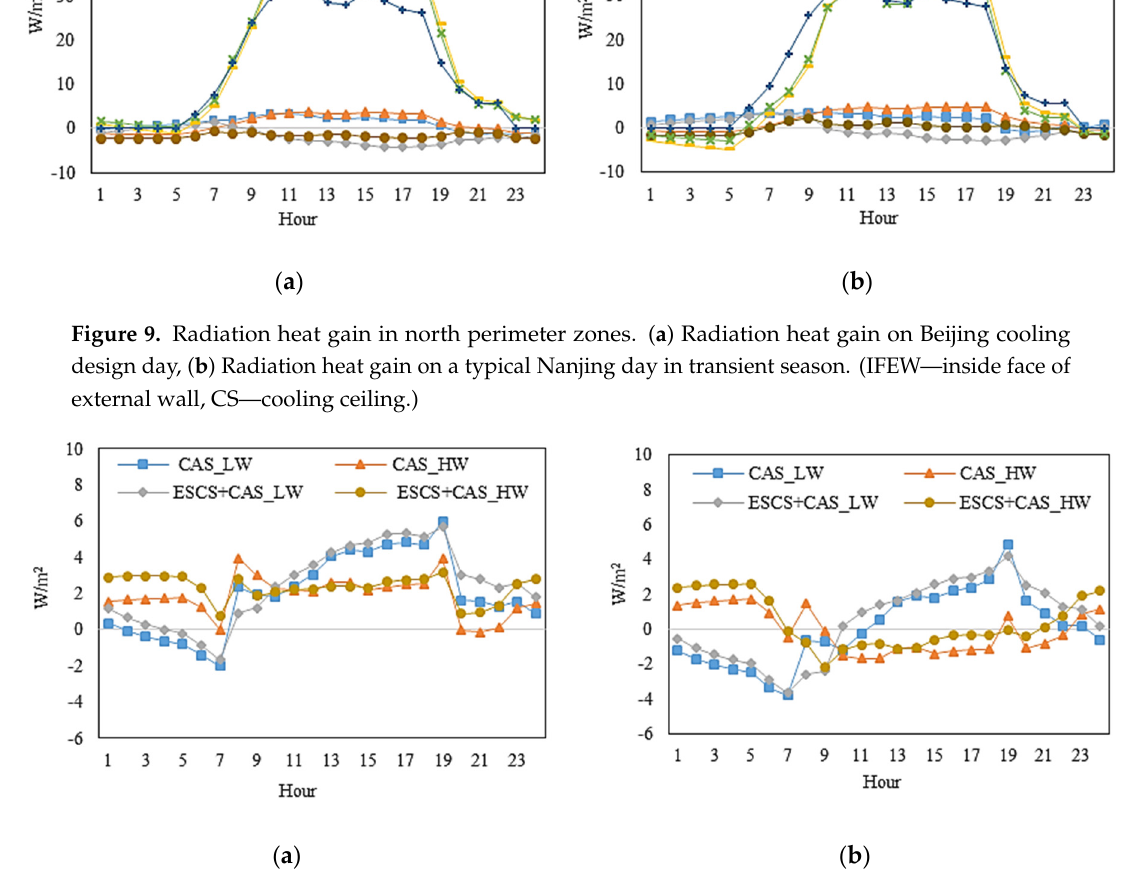
Figure 10. Conduction heat gains on the inside faces of external walls in north perimeter zones. ( a ) Conduction heat gain on a Beijing cooling design day. ( b ) Conduction heat gain on a typical Nanjing day in transient season.